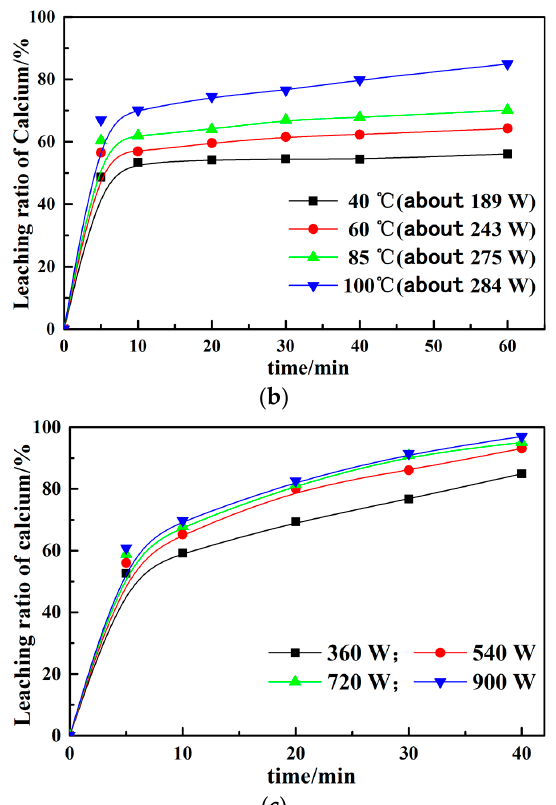
Figure 1. Calcium leaching ratio from the electric arc furnace (EAF) slag by NH 4 Cl under the different environments: ( a ) at constant temperature under water bath; ( b ) at constant temperature in the microwave field; ( c ) at constant power in the microwave field.